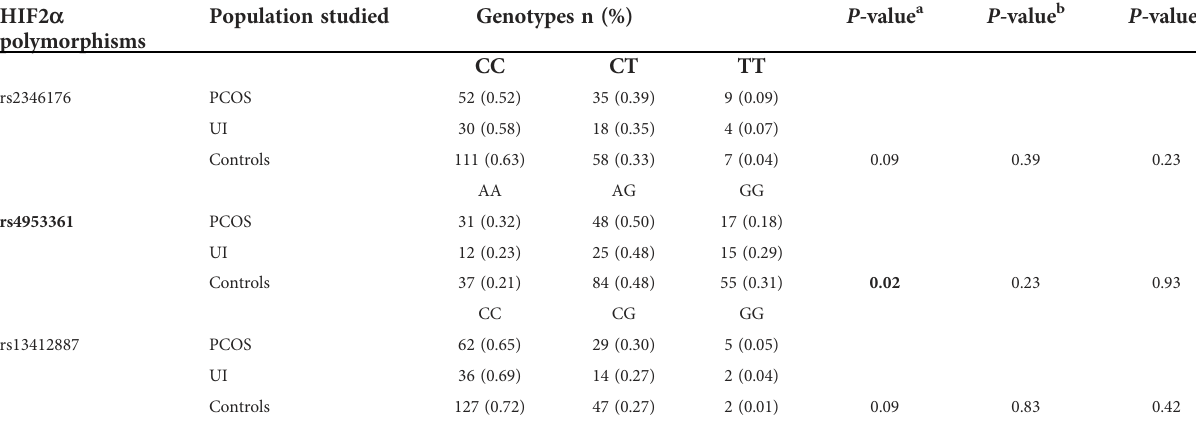
TABLE 3 Genotype frequency distribution of the HIF2 a polymorphisms in infertile patients with PCOS or UI and in the control group. HIF2 a polymorphisms